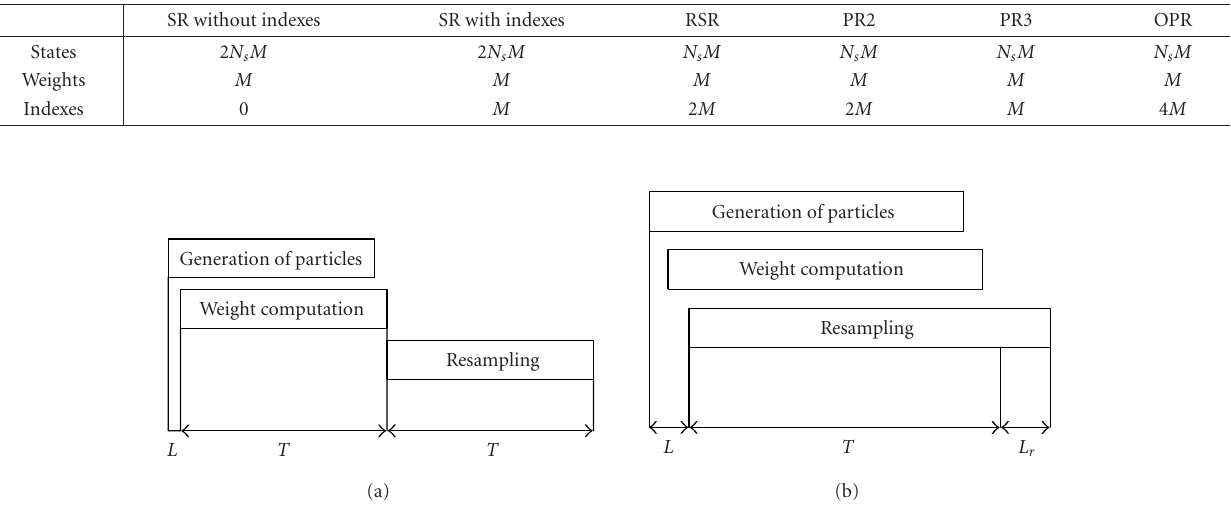
Figure 8: The timing of the PF with the (a) RSR or PR methods and (b) with the OPR